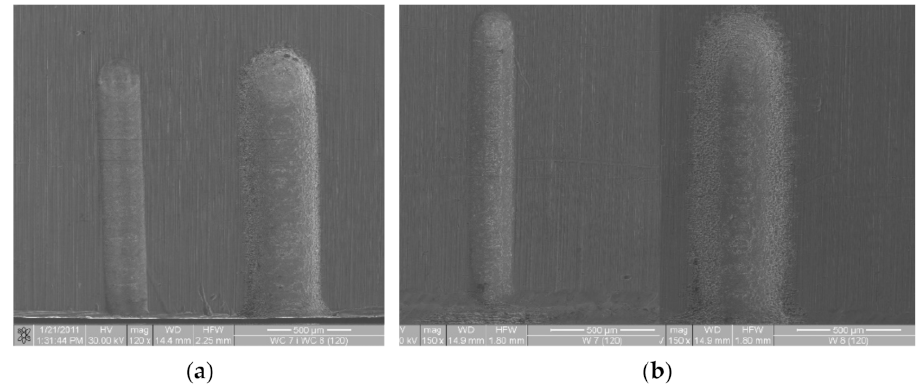
Figure 4. Comparison of the surfaces of the grooves obtained as a result of a single pass of electrode tool; workpiece material: 1.4301 stainless steel, electrode material: ( a )—WC, ( b )—W; electrode diameter D = 0.2 mm; machining parameters: velocity v p = 375 µ m/s, t on = 600 ns, interelectrode voltage U = 6 V (left) and U = 24 V (right)